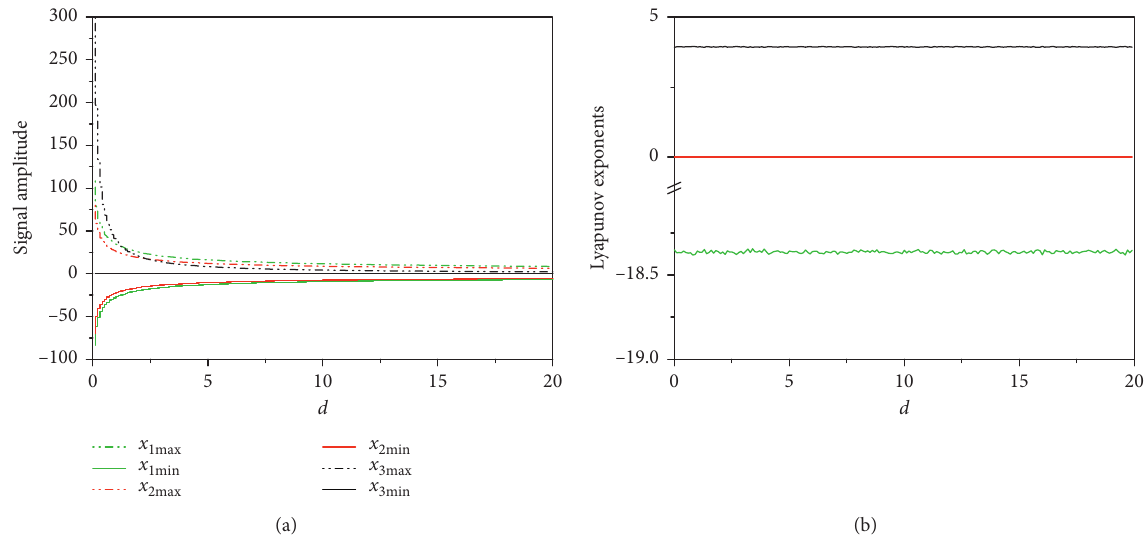
Figure 10: (a) Signal amplitude and (b) finite time Lyapunov exponent spectrum versus d .